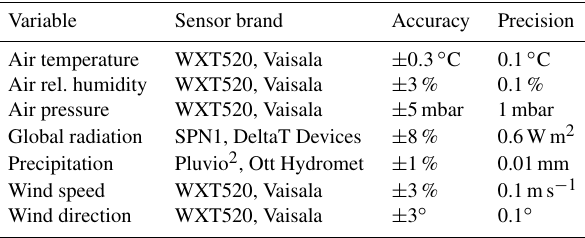
Table 1. Meteorological instrumentation in the Rott headwater catchment (instrumentation is part of the TERENO Pre-Alpine Ob- servatory at the Fendt